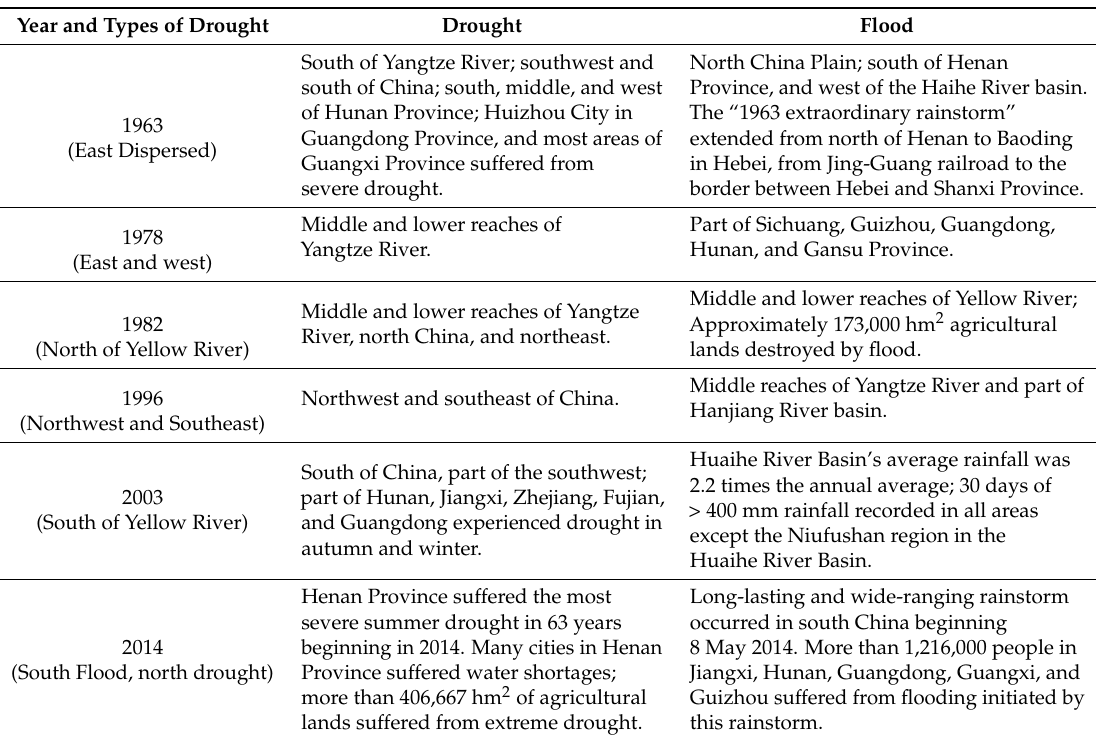
Table 2. A synthesized summary of drought and flood disaster (and type) distribution in China in 1963, 1978, 1982, 1996, 2003, and